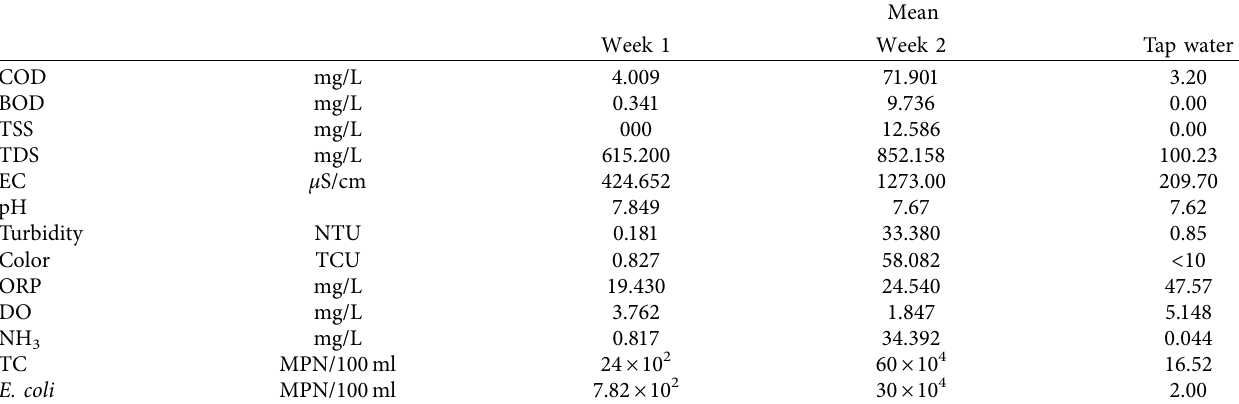
Table 6: Mean results for analyzed lab-scale setup efuent characteristics of tap water for weeks 1 and